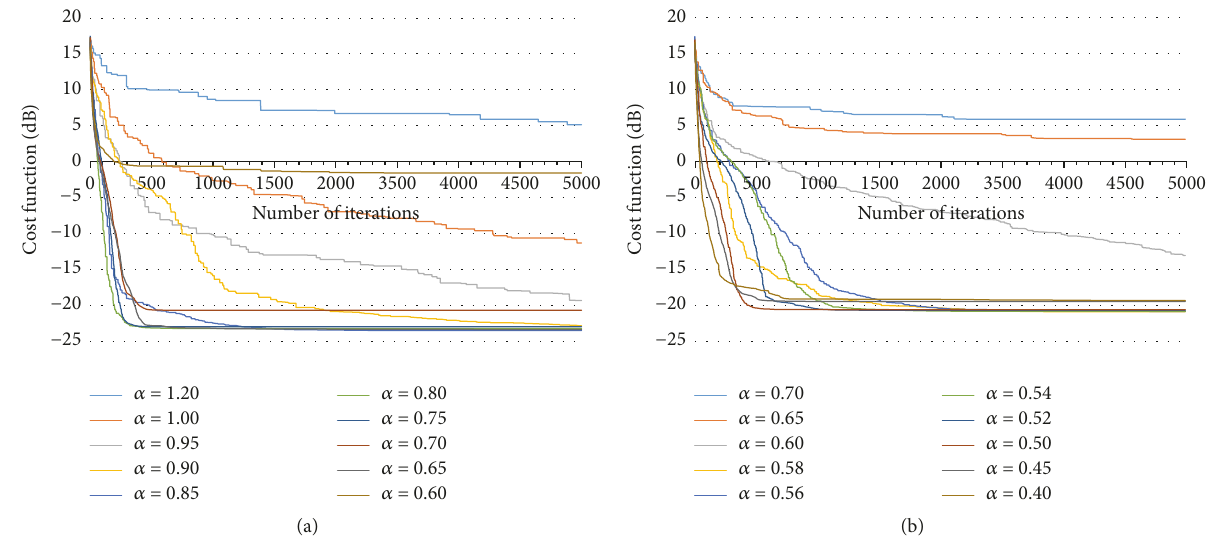
Figure 6: Performance results for various CE coefficients. (a) QPSO-Type 2-I. (b) QPSO-Type 2-II.